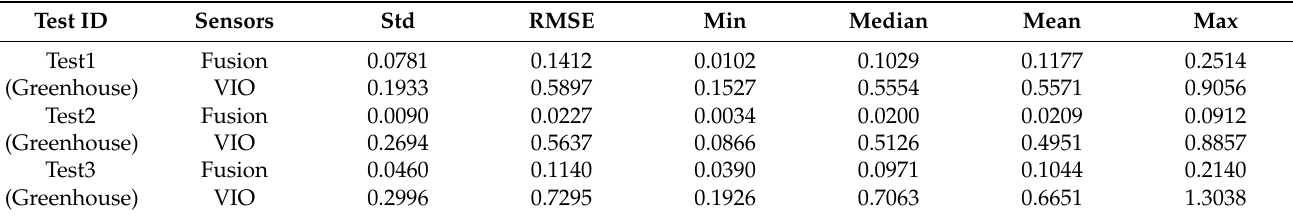
Table 1. Comparisons of the APE values between our proposed method and the